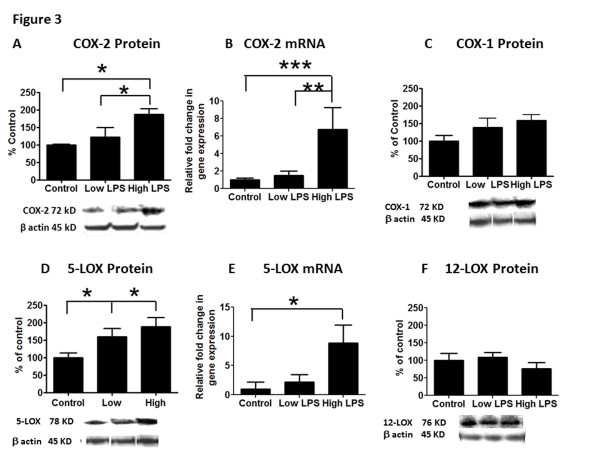
Protein levels of (A) COX-2, (C) COX-1, (D) 5-LOX and (F) 12-LOX (with representative immunoblots) in control, low- and high-dose LPS rat brain. Data are ratios of optical densities of protein to β-actin, expressed as percent of control, and were compared using one-way ANOVA, mean ± SEM (n = 8). mRNA levels of (B) COX-2 and (E) 5-LOX in control, low- and high-dose LPS, measured using real time RT-PCR. Data normalized to the endogenous control (β-globulin) and relative to control level (calibrator), using the ΔΔCT method. Comparisons between LPS were made using one-way ANOVA, mean ± SEM (n = 8), *p < 0.05, **p < 0.01.